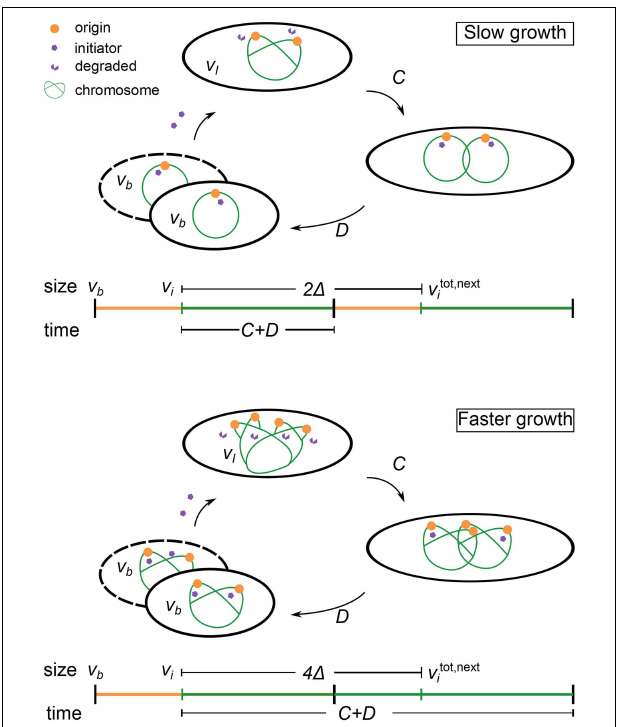
FIGURE 2 | Schematic of the regulation strategy of the multiple origins accumulation model. See text for the details of the model. Slow growth denotes 0 < C + D τ < 1 . Faster growth denotes 1 < ( C + D ) τ . In the above example, ( C + D ) τ < 2 .